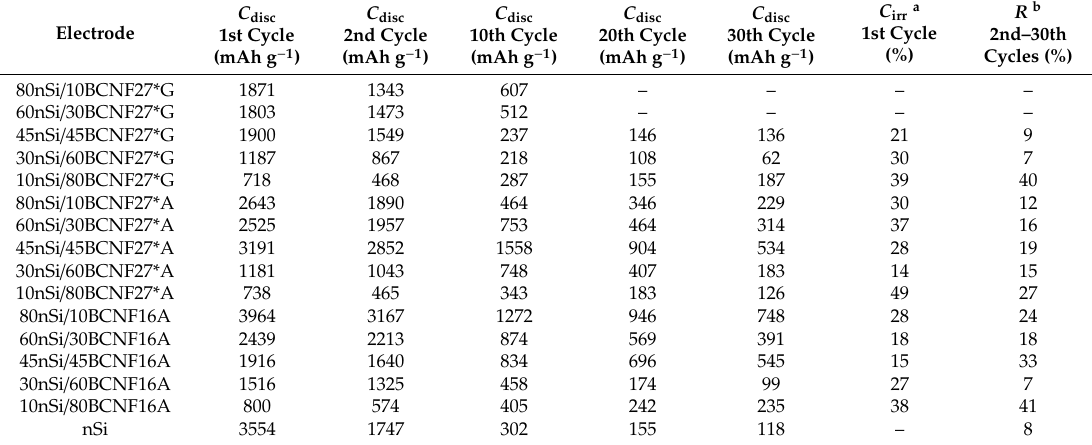
Table 1. Specific discharge capacity ( C disc ) in the 1st, 2nd, 10th, 20th and 30th cycles, irreversible capacity in the 1st cycle ( C irr ) and capacity retention ( R ) parameters from the galvanostatic cycling vs. Li / Li + of Si-based electrodes with di ff erent proportions of nSi and BCNFs, at an electric current density of 100 mA g − 1 .